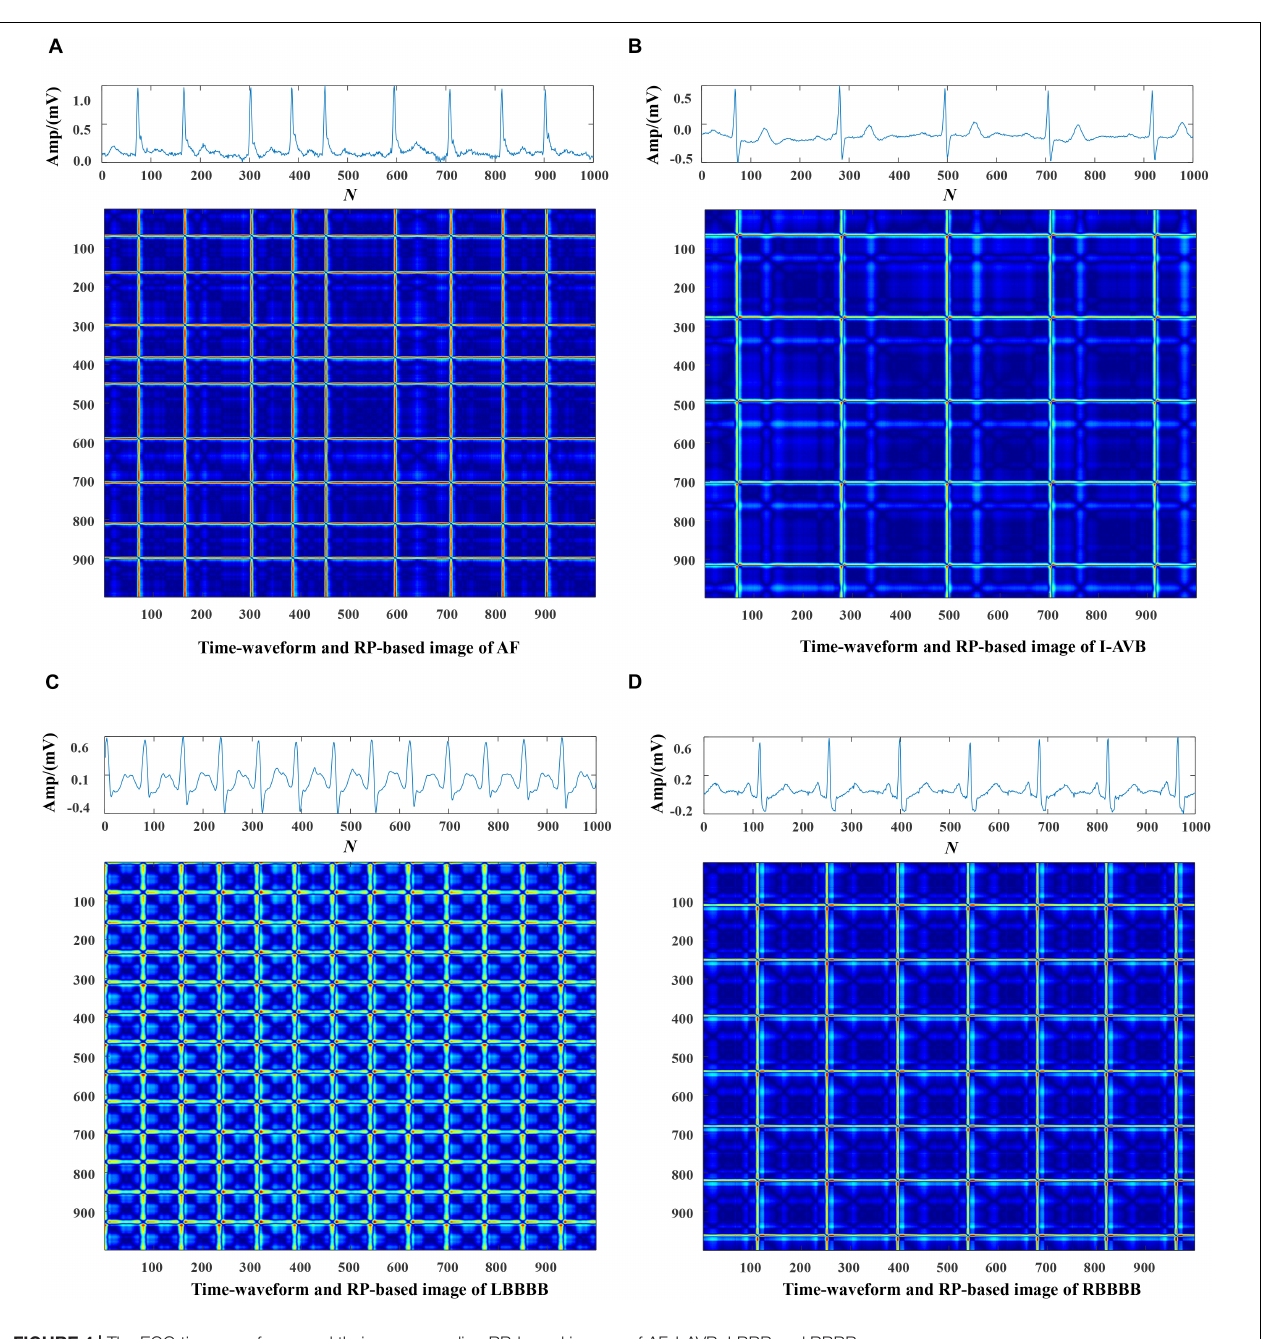
FIGURE 4 | The ECG time waveforms and their corresponding RP-based images of AF, I-AVB, LBBB and